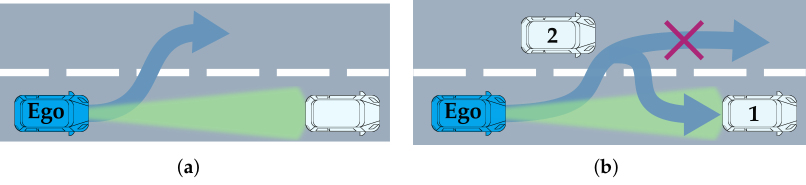
Figure 6. Lane change trajectory generation ( a ) a complete lane change trajectory planning; ( b ) an abortion trajectory